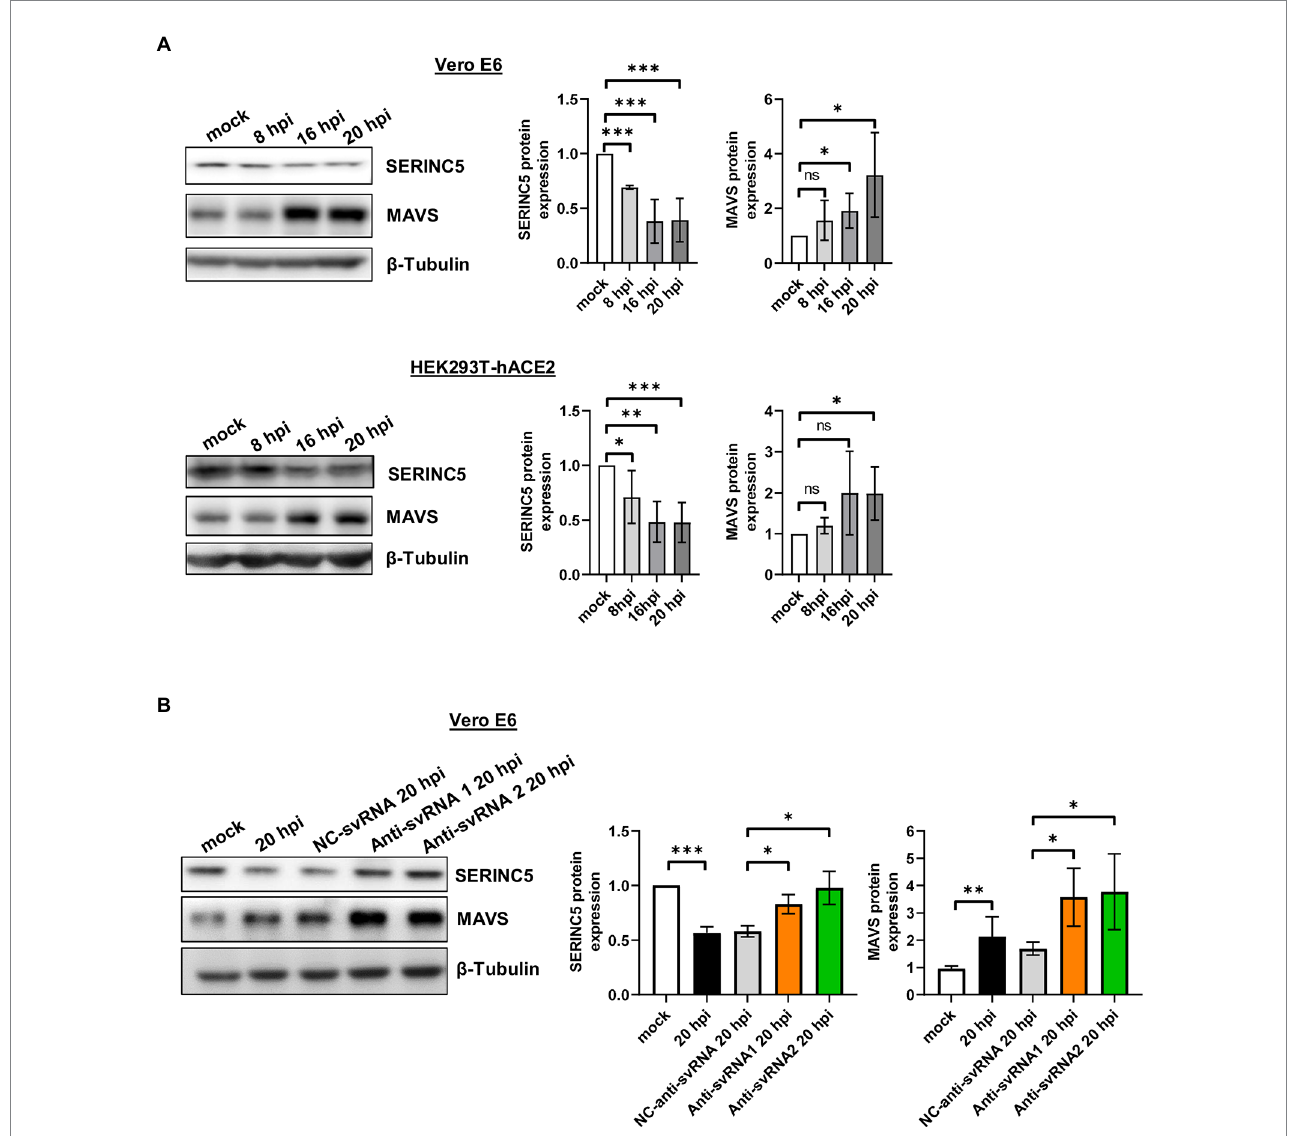
FIGURE 8 Analysis of MAVS expression during SARS-CoV-2 infection of Vero E6 and HEK293T-hACE2 cells treated or not with anti-sense molecules for svRNA 1 and 2. (A) Western blot analysis of SERINC5 and MAVS in Vero E6 (left) or HEK293T-hACE2 cells (right) mock-infected or infected with SARS-CoV-2 (MOI of 1 PFU/cell) at 8, 16, and 20 hpi. The scatter plot shows the densitometric analysis of MAVS protein normalized to β -tubulin and represented as fold change relative to non-infected (mock) cells. (B) Western blot analysis of MAVS in Vero E6 cells mock-transfected or transfected with anti-svRNA 1, anti-svRNA 2, or NC-anti-svRNA for 36 h and then infected with SARS-CoV-2 with a MOI of 1PFU/cell for 20 h. The scatter plot shows the densitometric analysis of MAVS and SERINC5 proteins normalized to β -tubulin, represented as fold change relative to non-transfected mock-infected (mock) cells. Differences from control values were found to be statistically significant at * p < 0.05, ** p < 0.01, and *** p <